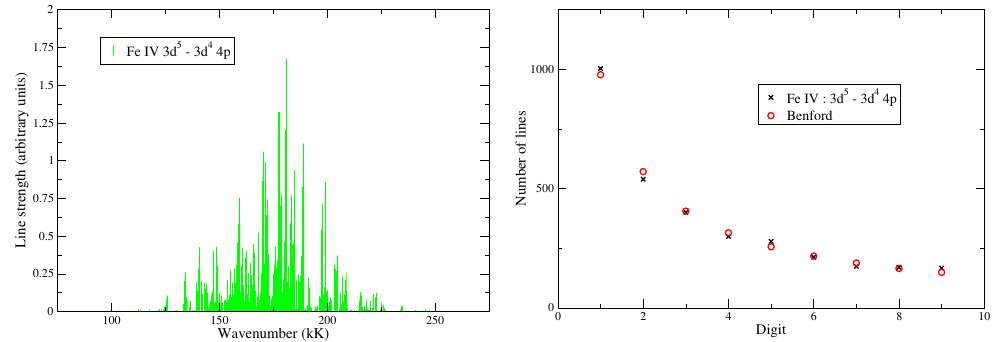
3 d 4 4 p (line strength as a function of energy) computed with Cowan’s Figure 10. Transition array 3 d 5 − code [56] and number of lines as a function of the first significant digit in the value of the strength. The fact that the line strengths follow Benford’s law, which is a consequence of